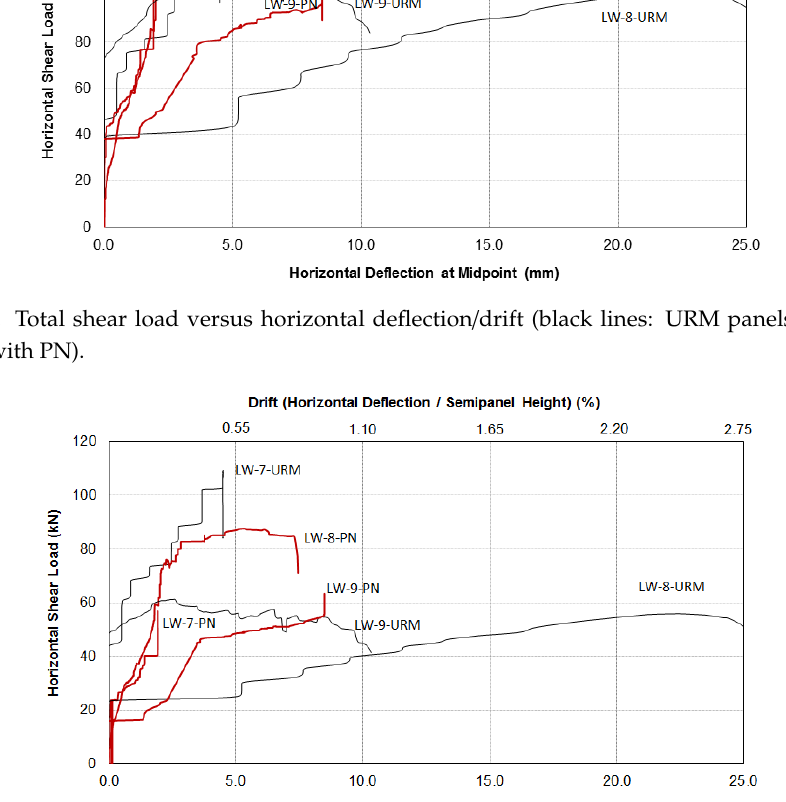
Figure 25. Typical failure mode of the URM wall panels: ( a ) brickwork panel and ( b ) stonework panel. Failure occurred when the loading produced diagonal cracks in the lowest half-panel and high bond stresses occurred between the polypropylene fabric and the masonry substrate, causing delamination of the reinforcement and the collapse of the panel. The delamination occurred because of poor bonding between FRP and the masonry surface due to the use of hydraulic mortar. The failure mode of all repaired wall panels (test labels LW-7-PN, LW-8-PN, and LW-9-PN) was similar: for a low level of the shear load, the bonding between the PN-reinforced mortar jacket and the masonry substrate was functional. This caused an interesting increase in the shear stiffness of the